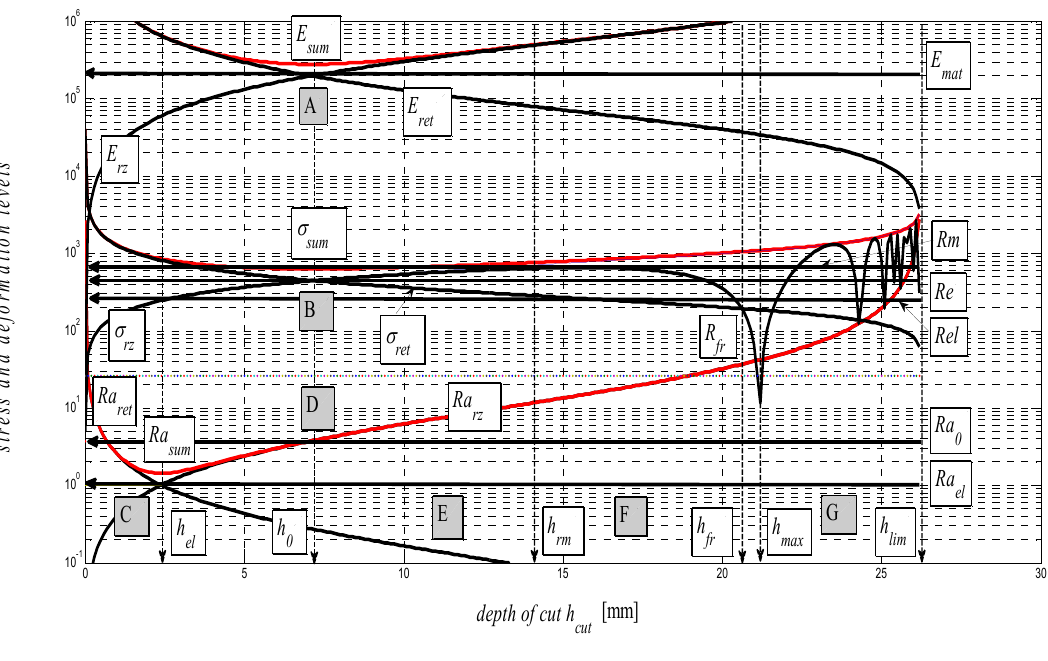
Figure 5. Stress and deformation levels of steel AISI 304 material, E mat = 195 GPa.